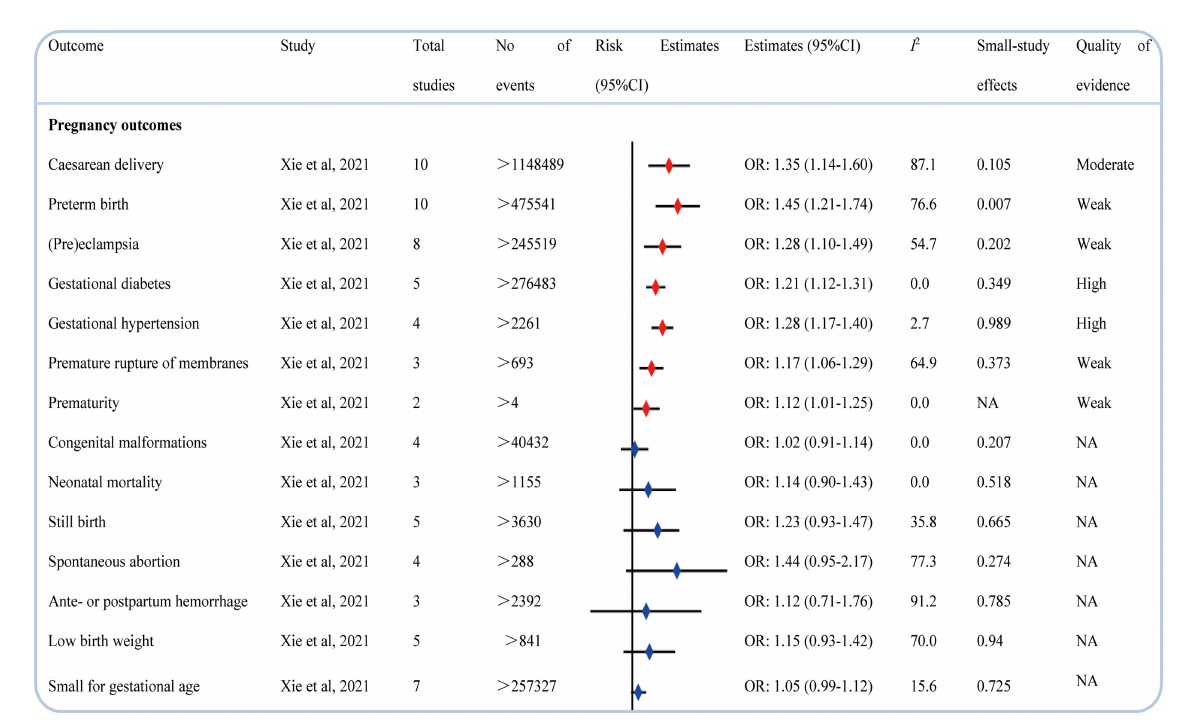
FIGURE7 Associations between psoriasis and pregnancy outcomes.